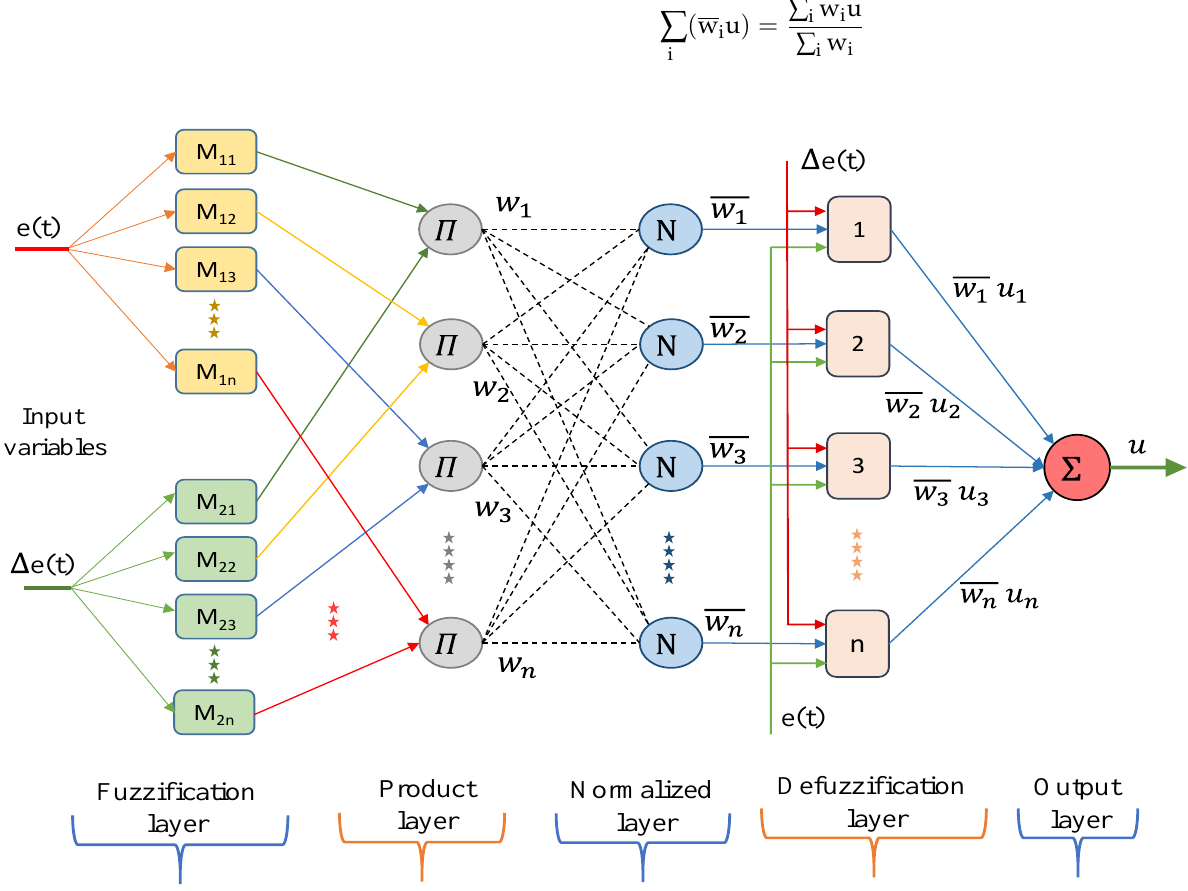
Figure 3. Schematic diagram of adaptive neuro-fuzzy inference system (ANFIS) architecture.